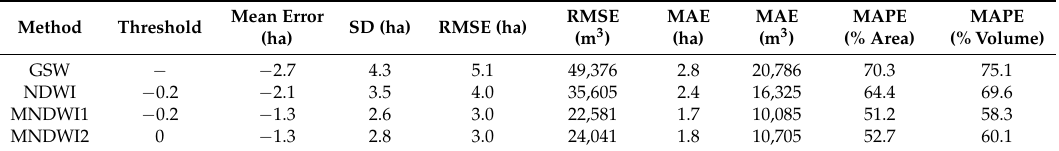
Table 1. Accuracy of 272 reservoir areal extents and volume equivalents derived from Global Surface